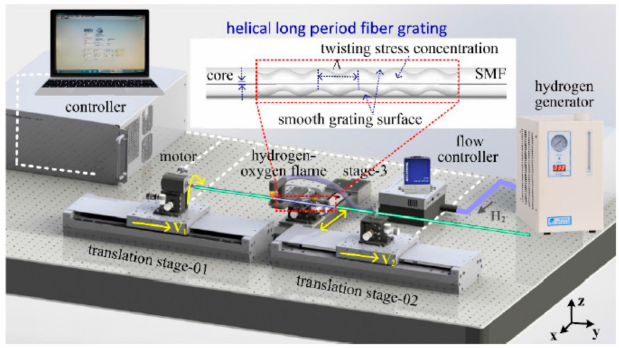
Figure 11. Experimental setup for fabricating the HLPFG